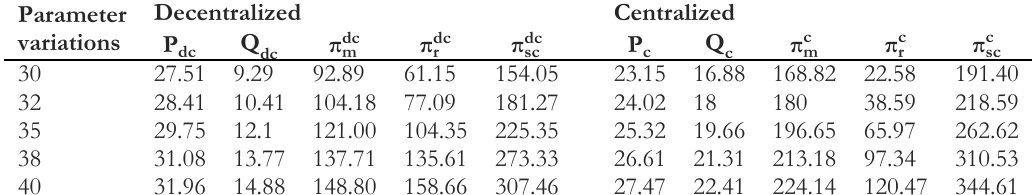
Table 6. Sensitivity analysis of the objective functions’ values for parameter α .